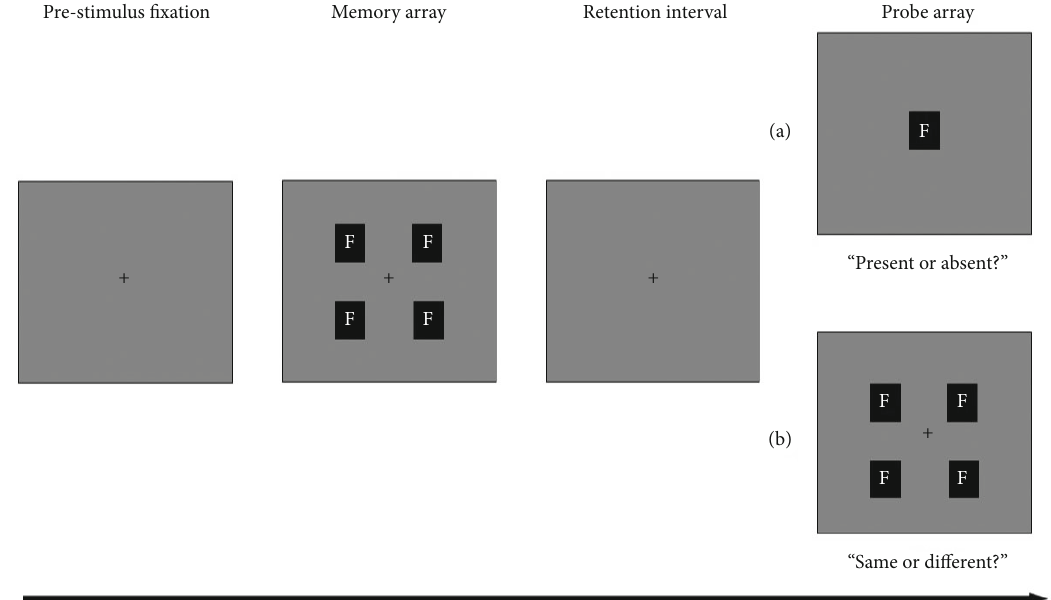
Figure 2: Two versions of the change detection paradigm. Participants need to detect (a) whether the single probe is present or absent in the memory array or (b) whether the probe array is identical to the memory array or one of the faces has changed. The letter F denotes a face, which can be emotional (positive or negative) or neutral in di ff erent studies. Note that the set size in the search array can di ff er across studies. Negative face: angry, fearful, sad, or disgusted expression face; positive face: happy expression face; neutral face: neutral expression